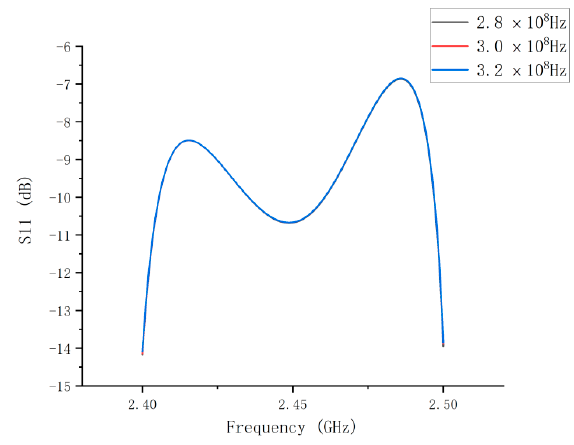
Figure 12. Comparison of S11 with different plasma collision frequencies.